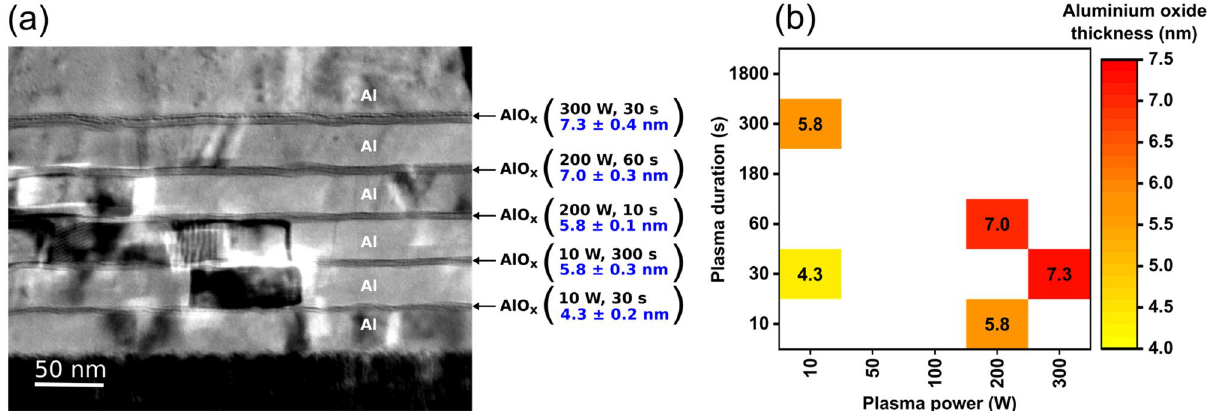
Figure 1. Thickness of plasma-grown aluminum oxide films. ( a ) Cross-sectional TEM image indicating the thicknesses of five AlO x films produced sequentially by the plasma-assisted surface oxidation of aluminum using five different combinations of plasma power and plasma duration. ( b ) Summary of the